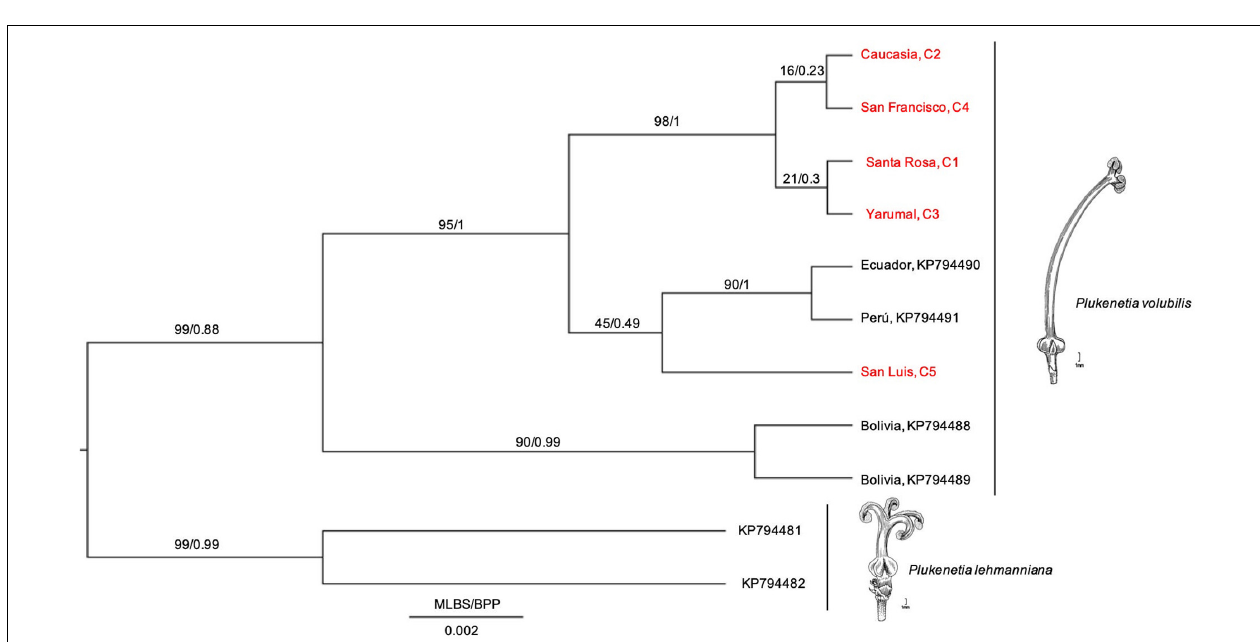
FIGURE 2 | Synteny analysis between Plukenetia volubilis (top) and Ricinus communis (bottom) chloroplast genomes. Homolog genes are connected by arrows. Two inversions are observed on the LSC (left) and on the SSC (right). Jagged edges and accompanying base pair numbers denote the start and end of a contig region automatically collapsed by SimpleSynteny due to no genes being present to make the figure more compact.